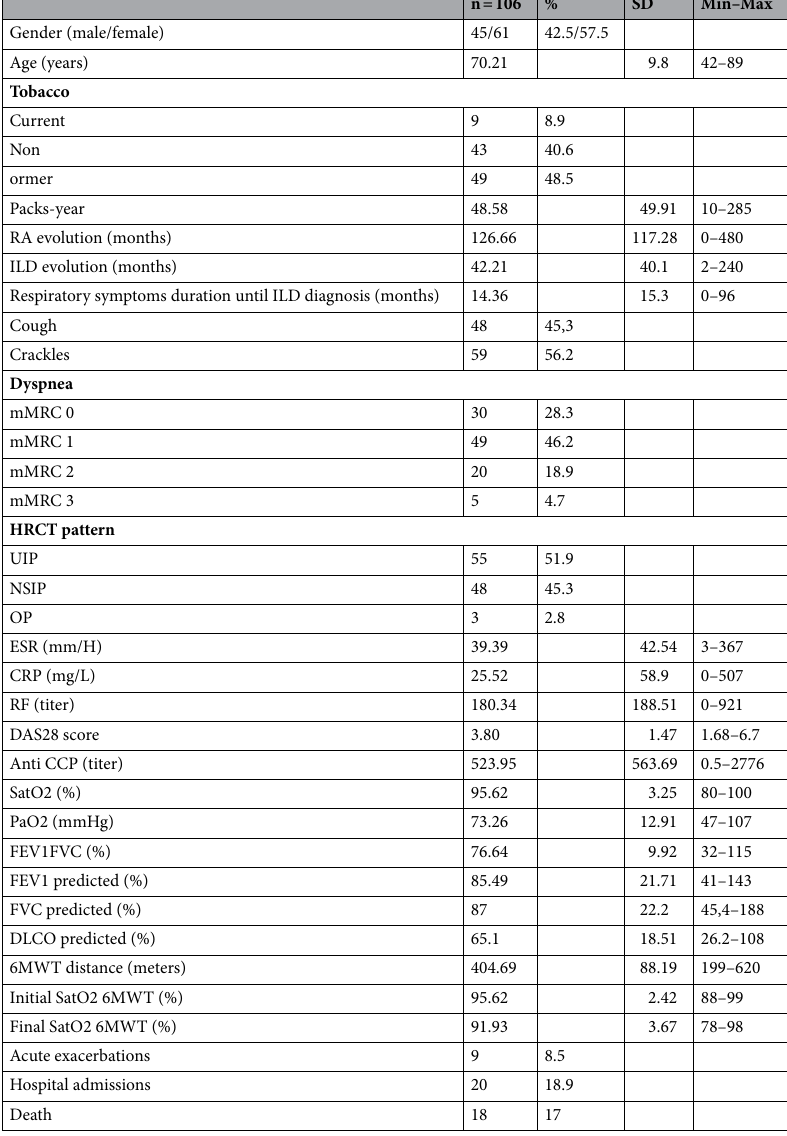
Table 1. Characteristics of the entire RA-ILD cohort. RA: rheumatoid arthritis; ILD: interstitial lung disease; HRCT: high-resolution computed tomography; UIP: usual interstitial pneumonia; NSIP: non-specific interstitial pneumonia; OP: organizing pneumonia; ESR: erythrocyte sedimentation rate ; CRP: C-reactive protein; RF: rheumatoid factor; DAS: disease activity score, Anti CCP: anti-cyclic citrullinated peptide, FEV1: forced expiratory volume in one second, FVC: forced vital capacity; DLCO: diffusion capacity for carbon monoxide; 6MWT: six minutes walking